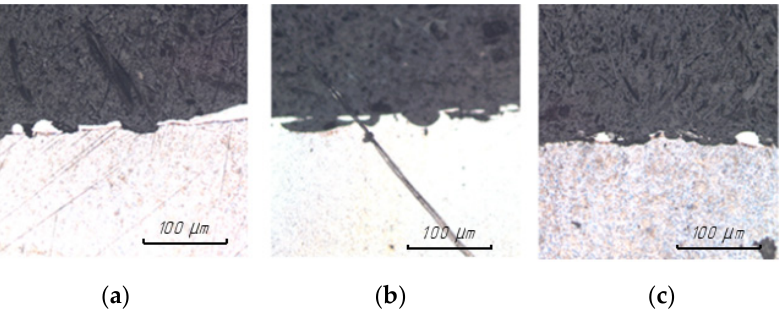
Figure 13. Surface structure of steel 15 at 100 × magnification after EDM in rough ET mode from: ( a ) copper; ( b ) graphite; ( c )